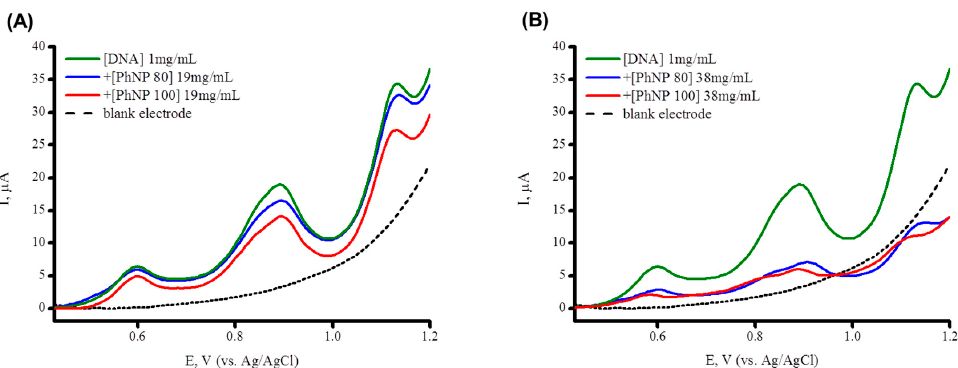
Figure 4. ( A ) DPVs of dsDNA and dsDNA in the presence of 19 mg/mL of PhNP80 or 19 mg/mL of PhNP100, ( B ) DPVs of dsDNA, and DPVs of dsDNA in the presence of 38 mg/mL of PhNP80 or 38 mg/mL of PhNP100.